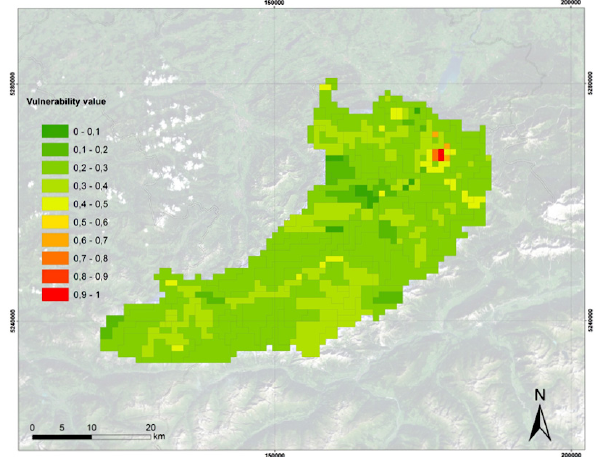
Figure 9. Salzach River case study. Socio-economic Vulnerability unit.